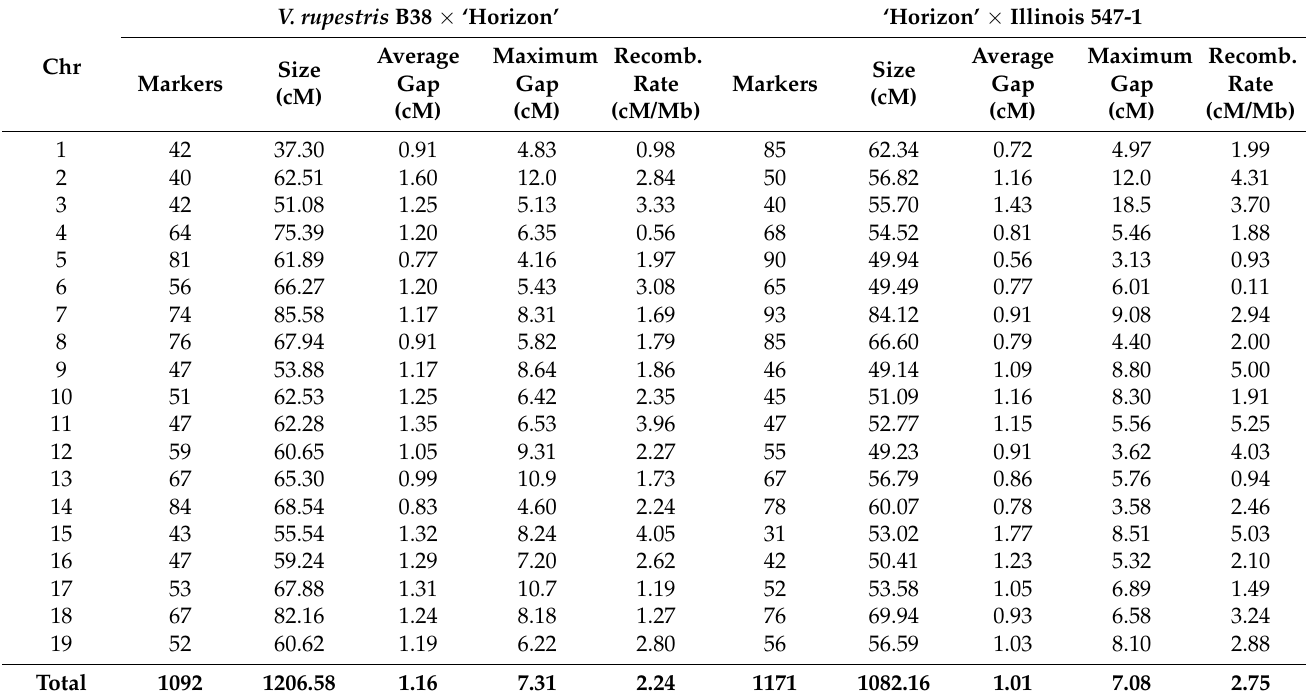
Table 1. Features of the V. rupestris B38 × ‘Horizon’ and ‘Horizon’ × Illinois 547-1 sex-averaged linkage maps.